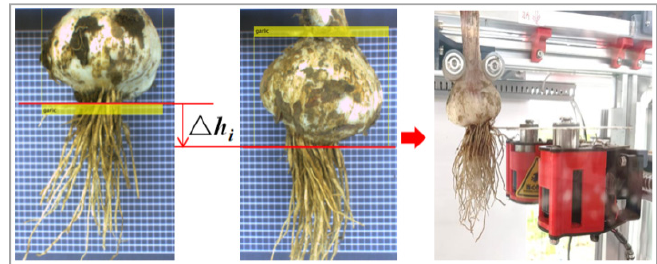
Figure 5. Schematic diagram of the adjustment method.